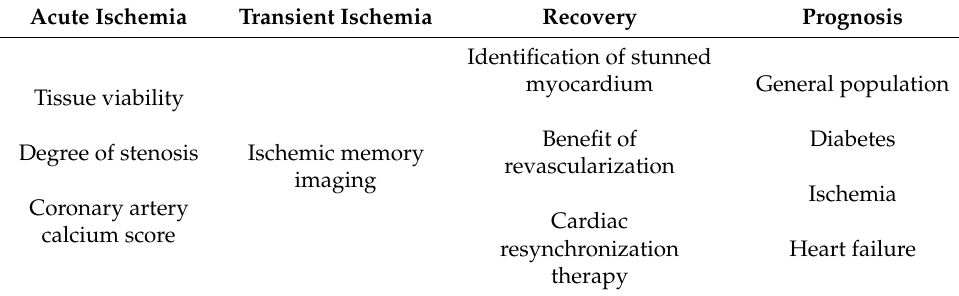
Table 2. Research areas and potential clinical applicability of PSS and